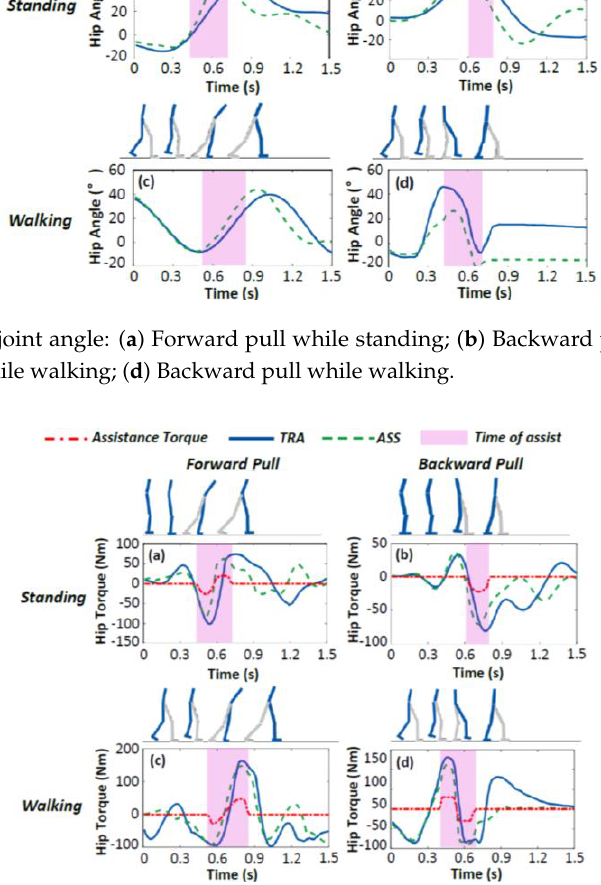
Figure 16. The hip joint torque: ( a ) Forward pull while standing; ( b ) Backward pull while standing; ( c ) Forward pull while walking; ( d ) Backward pull while